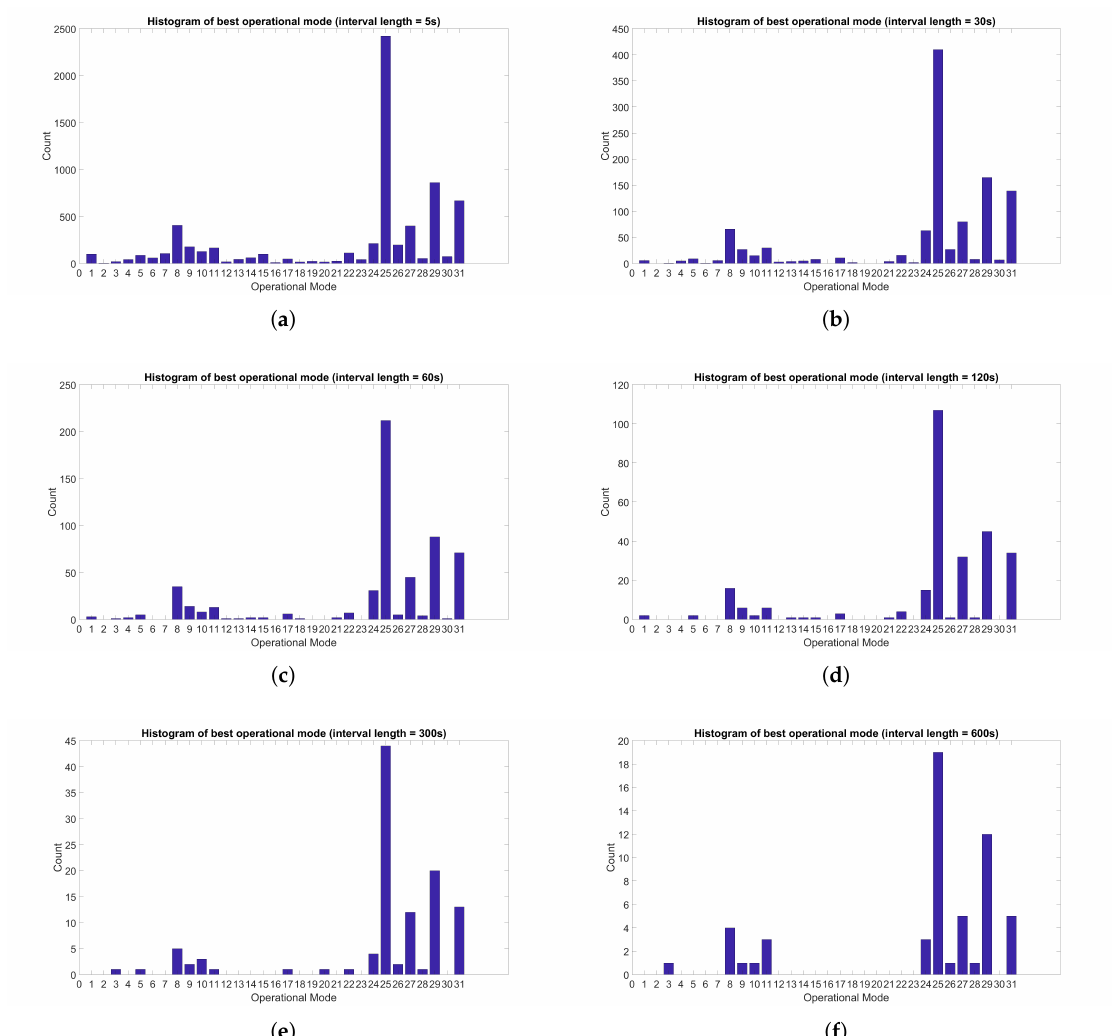
Figure 11. These histograms show how often each mode is selected during each of the different interval lengths. ( a – f ) show interval lengths 5, 30, 60, 120, 300, and 600 s respectively.